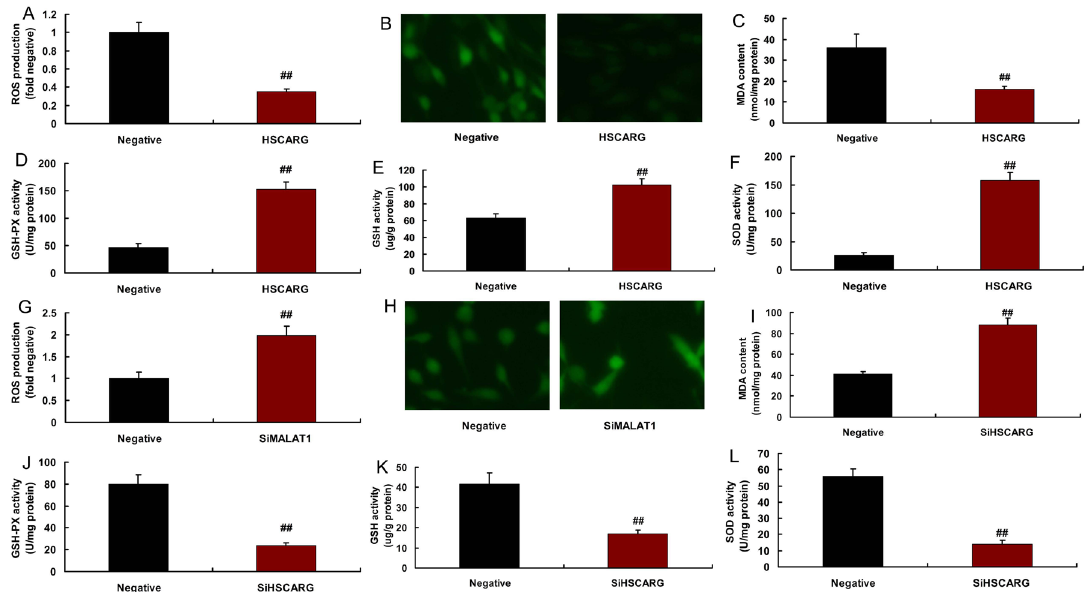
Fig. 3 - HSCARG reduced reactive oxygen species (ROS)-oxidative stress in in vitro model. ROS production levels (A and B), malondialdehyde (MDA), glutathione peroxidase (GSH-PX), glutathione (GSH), and superoxide dismutase (SOD) levels (C, D, E, and F) in in vitro model by overexpression of HSCARG; ROS production levels (G and H), MDA, GSH-PX, GSH, and SOD levels (I, J, K and L) in in vitro model by downregulation of HSCARG. Negative=negative mimic group; HSCARG=overexpression of